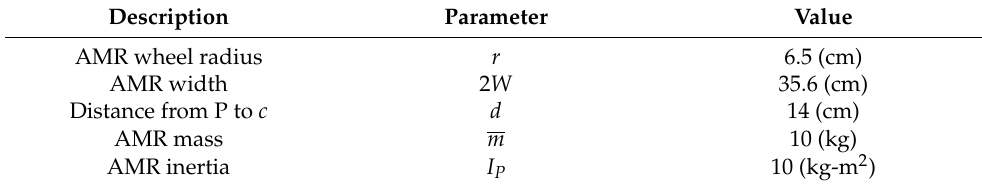
Table 1. System parameters of the controlled